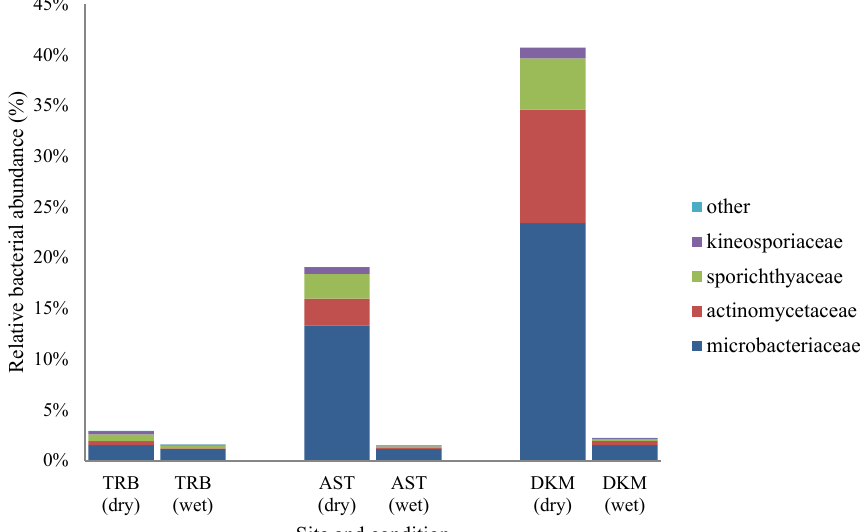
Fig. 4: Relative abundance of Actinobacteria (by family) of samples taken from Newtown Creek on dry (09/08/16) and wet (09/15/17) days from TRB, AST and DKM sites